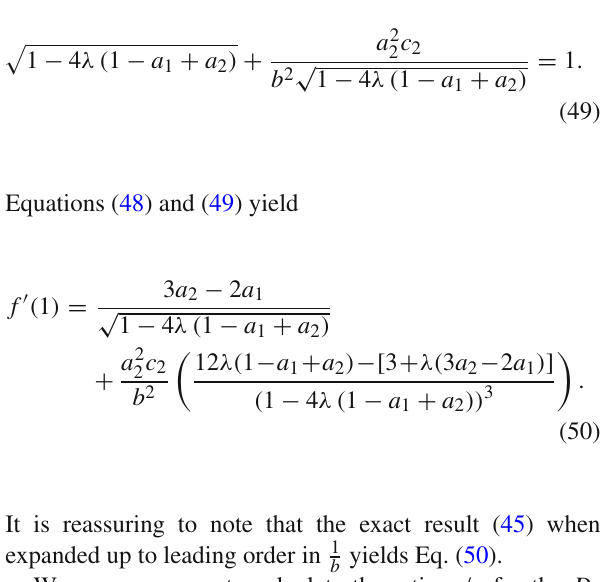
Fig. 2 Viscosity to entropy ratio in the limit of zero charge